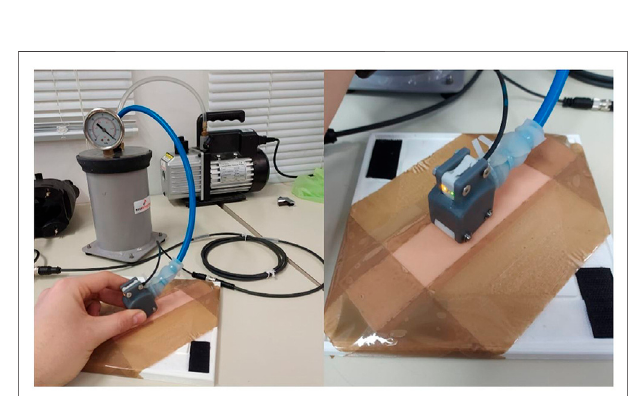
FIGURE8| Test bench forsteady statetime evaluation and repeatability evaluation